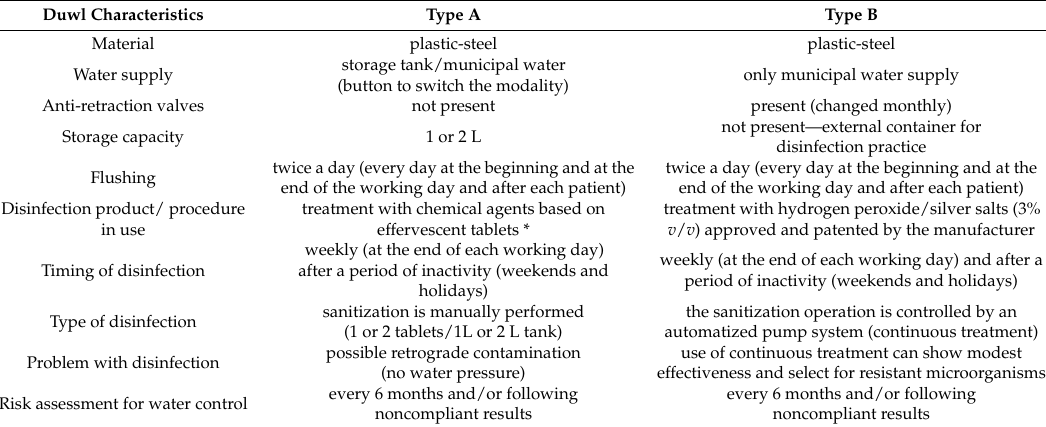
Table 1. DUWL characteristics and maintenance protocols